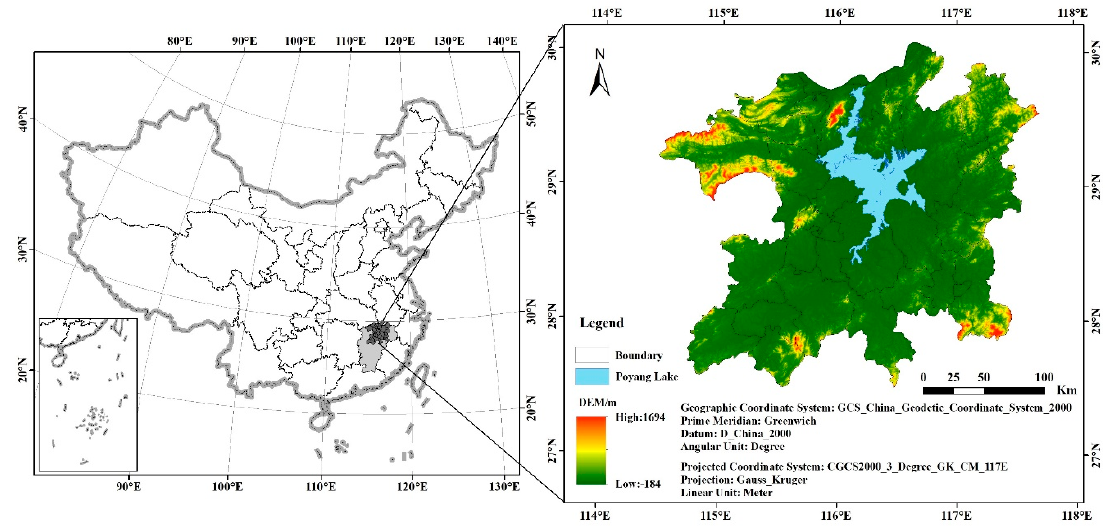
Figure 1. Location and topography of the Poyang Lake Eco-Economic Zone (PLEEZ).